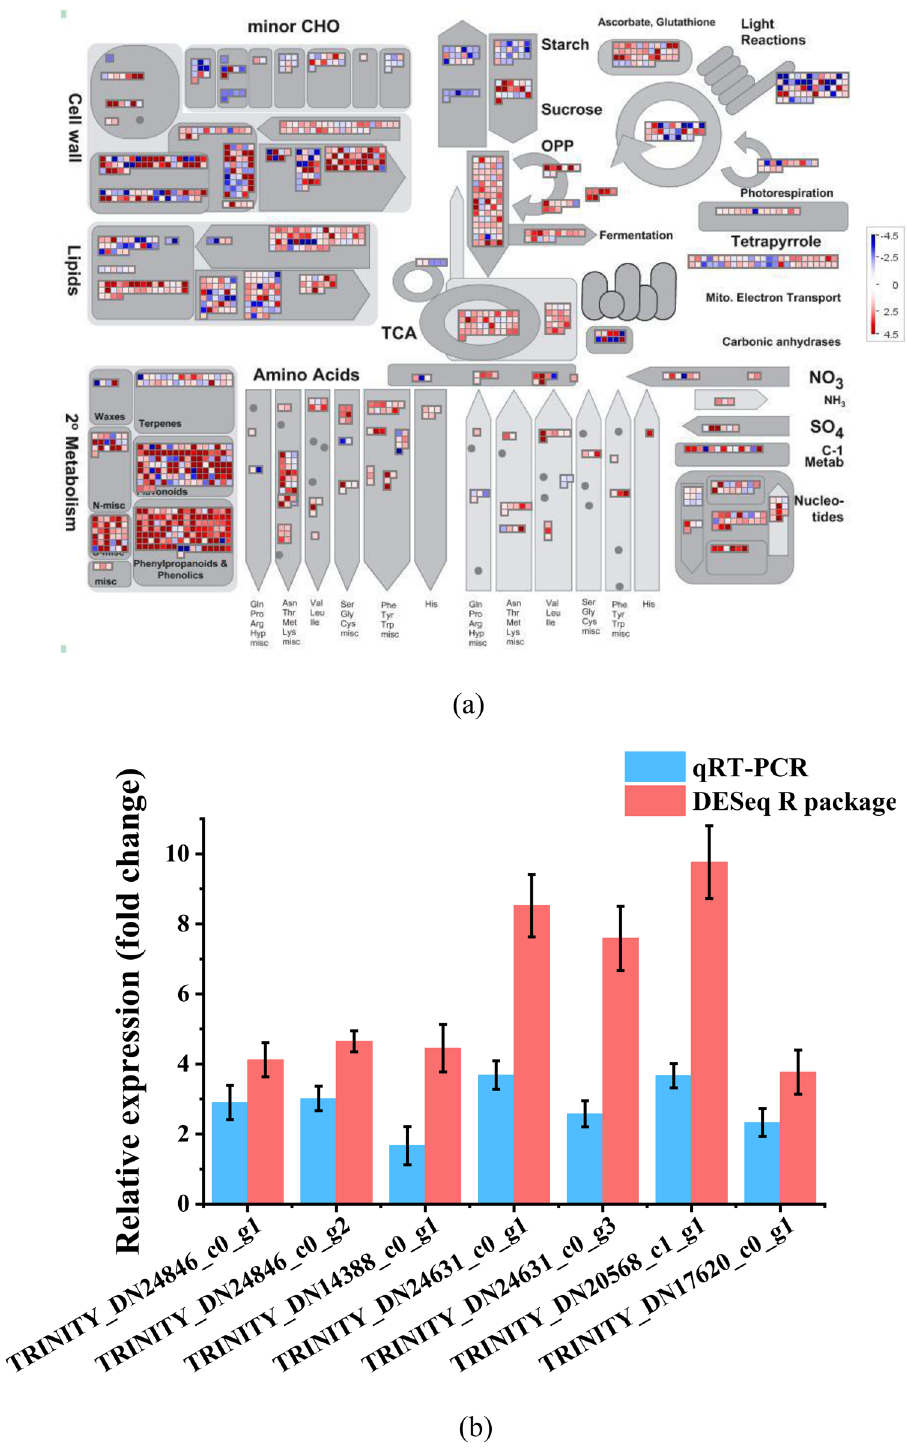
Figure 4. ( a ) Overview of DEGs involved in various metabolic processes under different treatments. Red represents upregulated genes, while blue represents downregulated genes. ( b ) Quantitative RT-PCR validation of gene